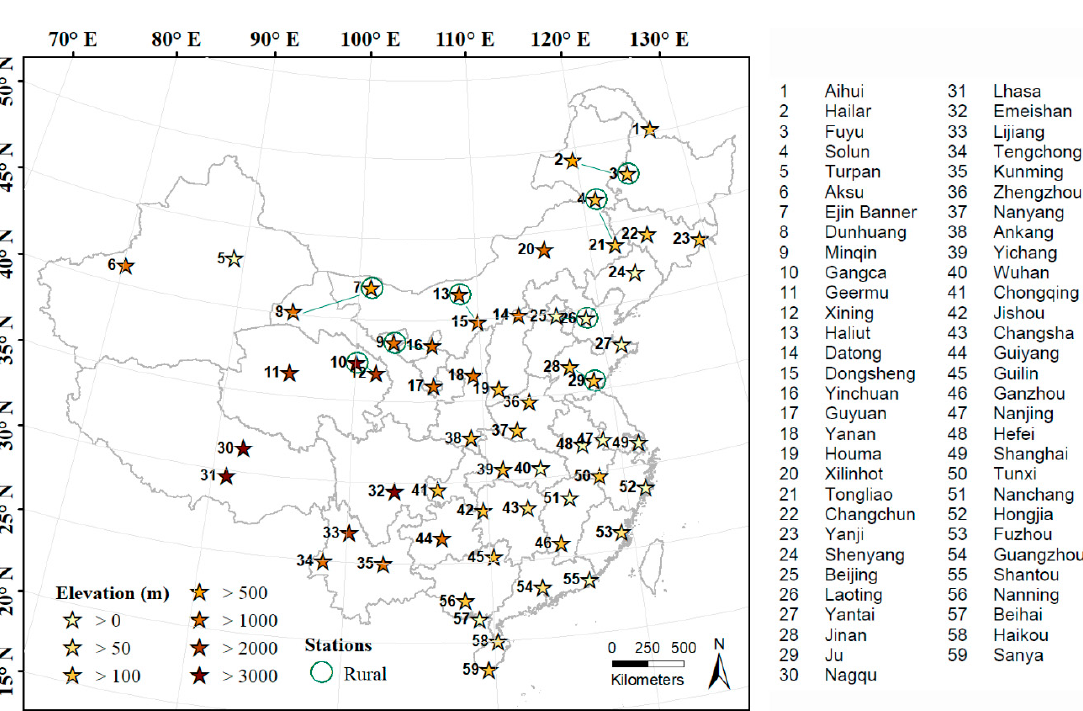
Figure 2. Spatial distribution of the selected 59 stations with homogenous ground observations of surface solar radiation for 1993–2015. The color scale of the star symbols indicates the elevation (m) of the stations. Rural stations have been especially highlighted by circles, with straight lines linking them to the nearby urban stations.